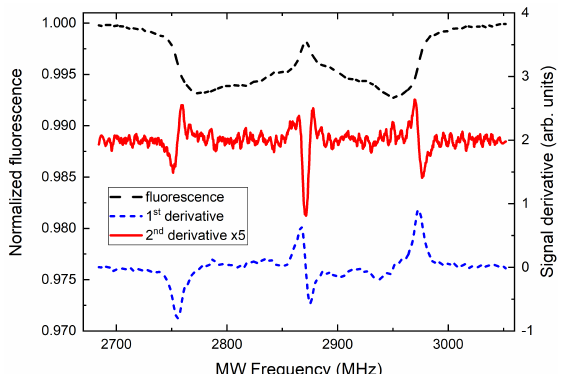
Figure 3. ODMR signals used for magnetometry: spectrum in 3.7 mT field from Figure 2c (dashed black) and its first (dotted blue) and second (solid red, vertically offset) derivatives. Zero-crossings of both the latter signals are independent on the fluorescence intensity and may be used for temperature and magnetic-field